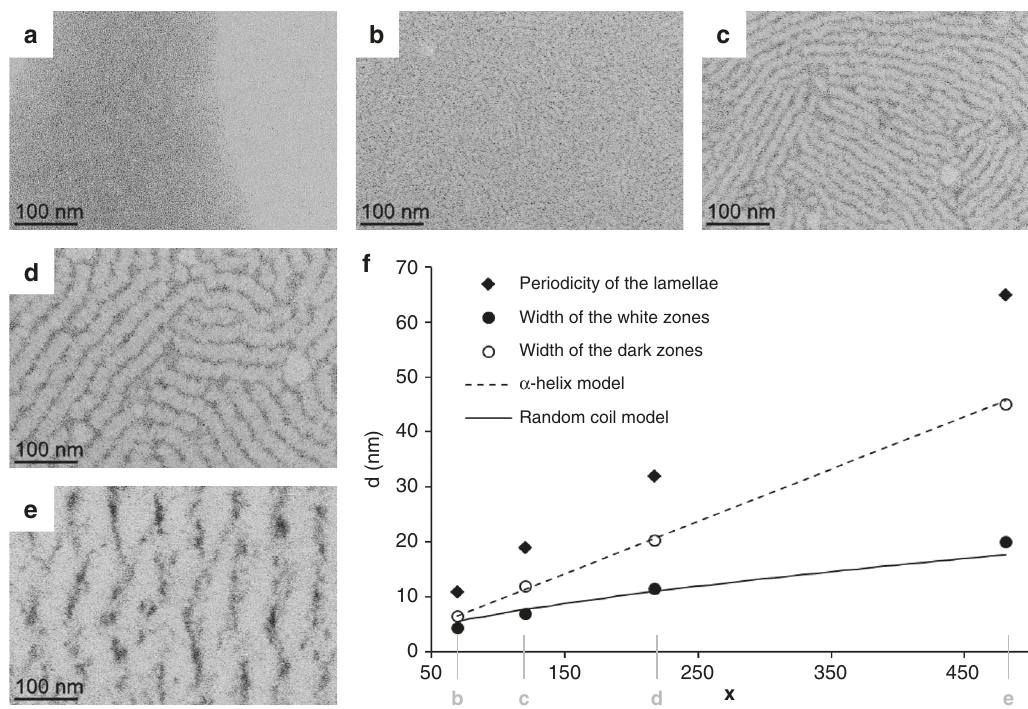
Fig. 4 Effect of the degree of polymerization. TEM micrographs of assemblies between platinum nanoparticles and: a PBLG1 ; b PBLG2 ; c PBLG3 ; d PBLG4 ; and e PBLG5 . f , Evolution of average characteristics as a function of the degree of polymerization x (the α -helix model curve represents the length of the polymer as shown in Fig. 1c for x = 60; the random coil model curve represents the diameter of gyration evolution of excluded volume random coil model with R 0 = 0.22 and ν = 0.6). Positions corresponding to the micrographs of Fig. 4 b , c , d , and e are made explicit on the x